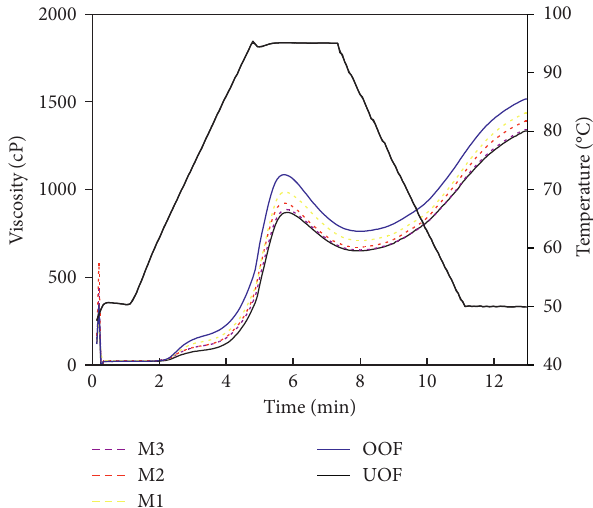
Figure 5: RVA curves of wheat flour added with different ratios of overozonized wheat